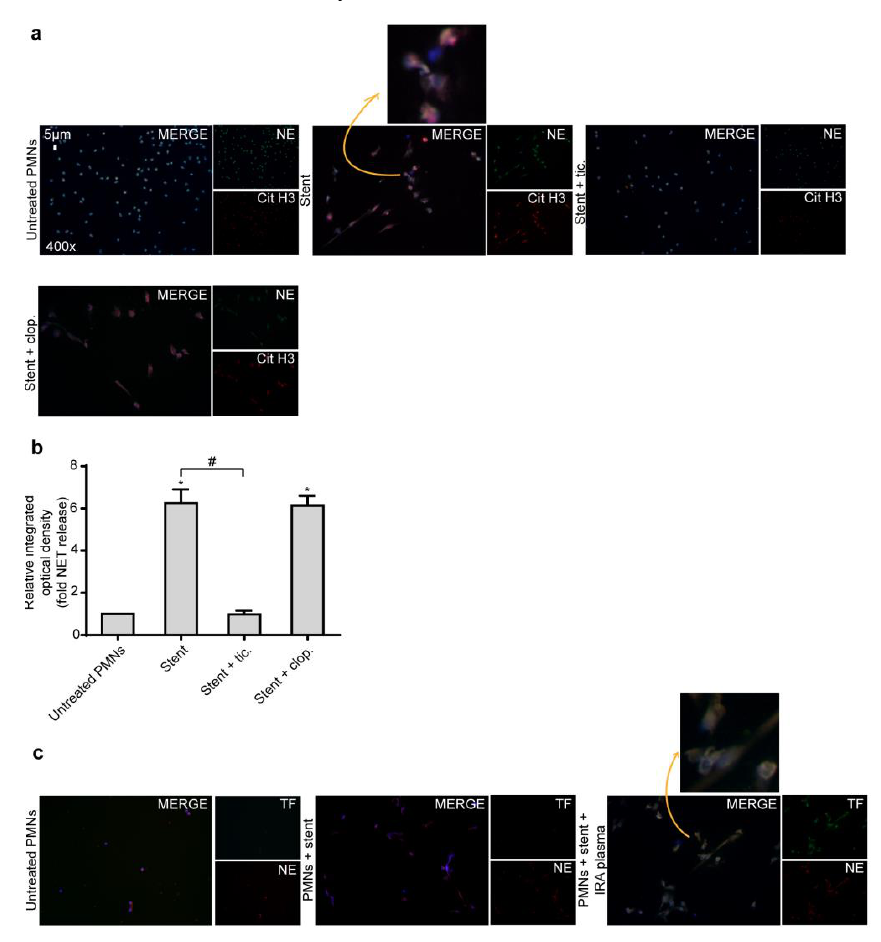
Figure 6. Coronary stents induce NET formation. ( a ). Fluorescence microscopy for cit-H3 / NE staining in control neutrophils treated with stent and with or without pre-treatment with Ticagrelor or Clopidogrel. One representative out of six independent experiments is shown. Original magnification: 400 × , Scale bar: 5 µ m. Blue: DAPI, Green: NE, Red: cit-H3. ( b ). MPO-DNA complex levels in NET structures from control neutrophils treated with stent, with or without pre-treatment with Ticagrelor or Clopidogrel, as assessed by ELISA. Relative integrated optical density was calculated when compared to control NETs value. Data from six independent experiments presented as mean ± SD. Statistical significance *, # p < 0.05. All conditions were compared to untreated / control conditions and statistical significance is indicated by the symbol “*”. Any further statistical significance of other comparisons is indicated by the symbol “#”. ( c ). Fluorescence microscopy for TF / NE staining in control neutrophils treated with stent and IRA plasma. One representative out of six independent experiments is shown. Original magnification: 400 × , Scale bar: 5 µ m. Blue: DAPI, Green: TF, Red: NE. Polymorphonuclear neutrophils